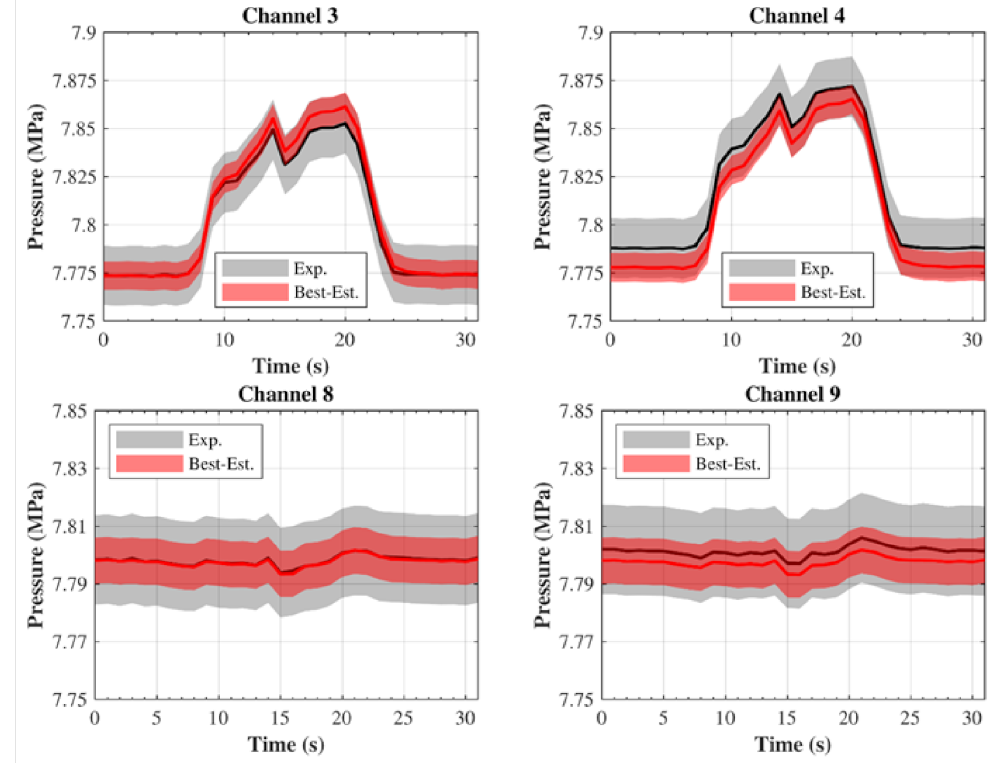
Figure 10. Outlet coolant pressure—300 kW/m 2 , 0% valve opening scenario.